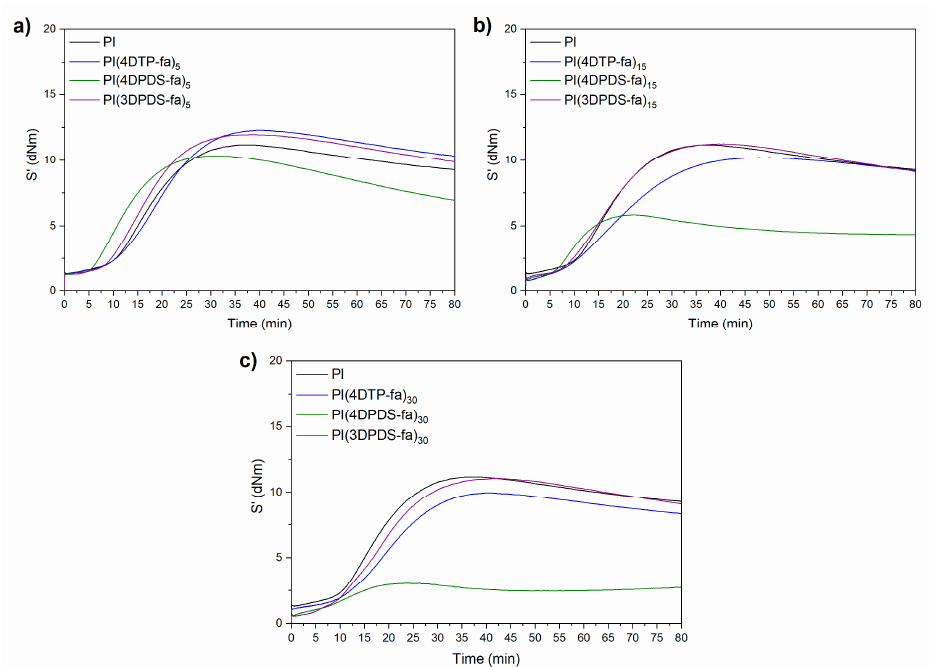
Figure A29. ( a ) MDR measurements of the rubber compounds with 5 phr of Bz and the reference; ( b ) MDR measurements of the rubber compounds with 15 phr of Bz and the reference; ( c ) MDR measurements of the rubber compounds with 30 phr of Bz and the reference.